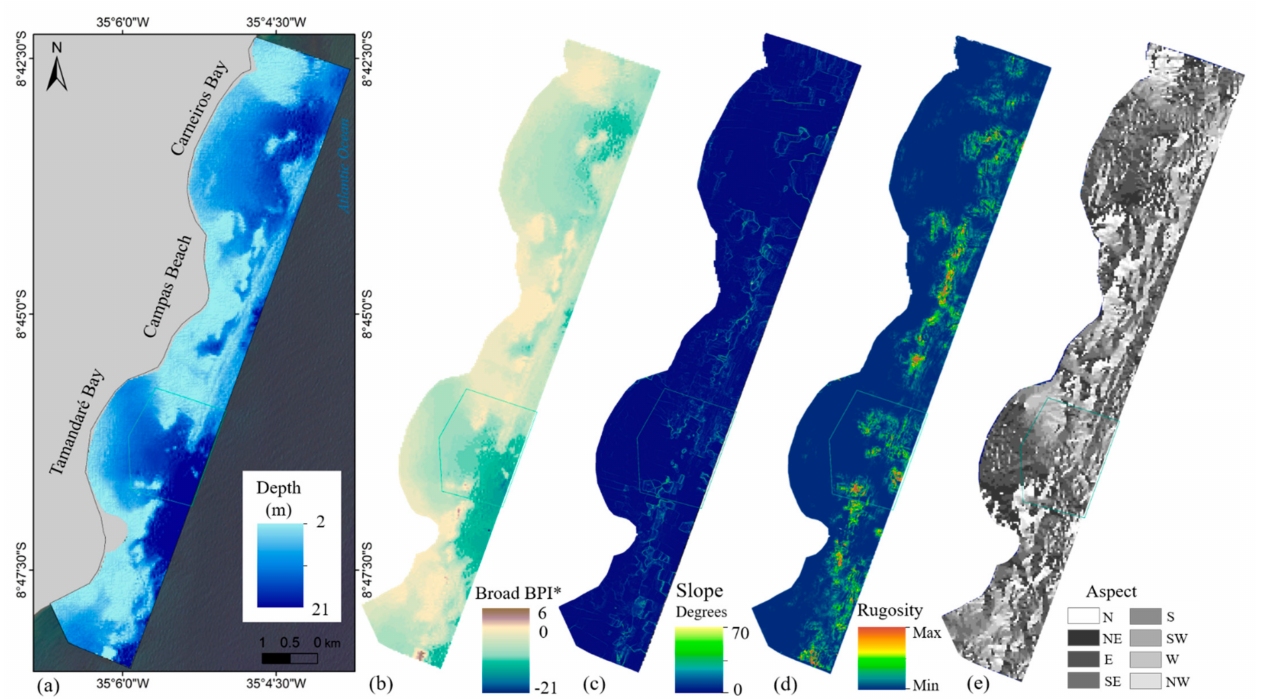
Figure 7. Topographical layers used as environmental variables in the predictive modeling of Millepora alcicornis . The hollow blue polygon on the images shows the location of the no-take zone. ( a ) Bathymetric dataset; ( b ) broad bathymetric position index (BPI); ( c ) slope; ( d ) rugosity; ( e ) aspect.